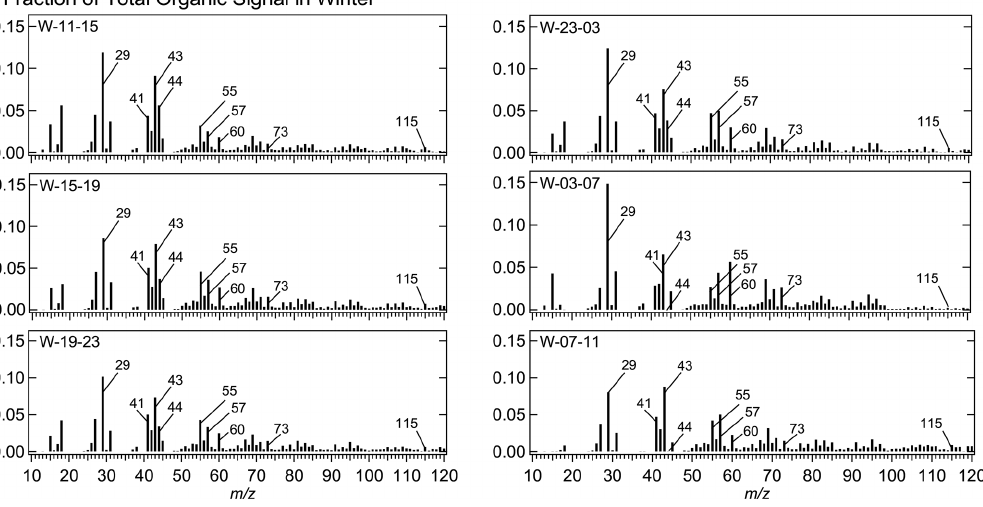
Figure 6. The mass spectrum of time-of-day PMF biomass burning organic aerosol (BBOA) factor in winter 2017. The mass spectra show important differences across the time-of-day